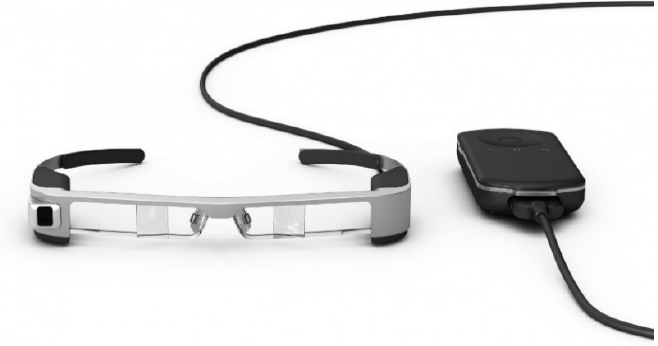
Figure 5. Android Smart Glasses where the implementation a test was performed.